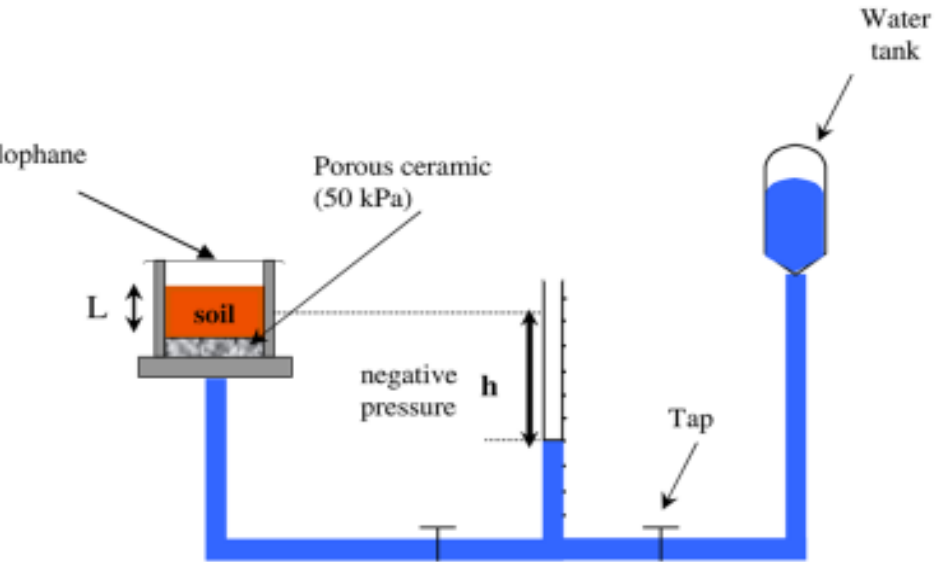
Figure 5: Schematic representation of the tensiometric method for the measurement of suction (Feia et al.